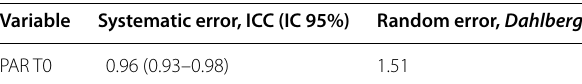
Table 4 Variables associated with of orthodontic treatment duration (dependent variable) by the univariate and multiple linear regression model